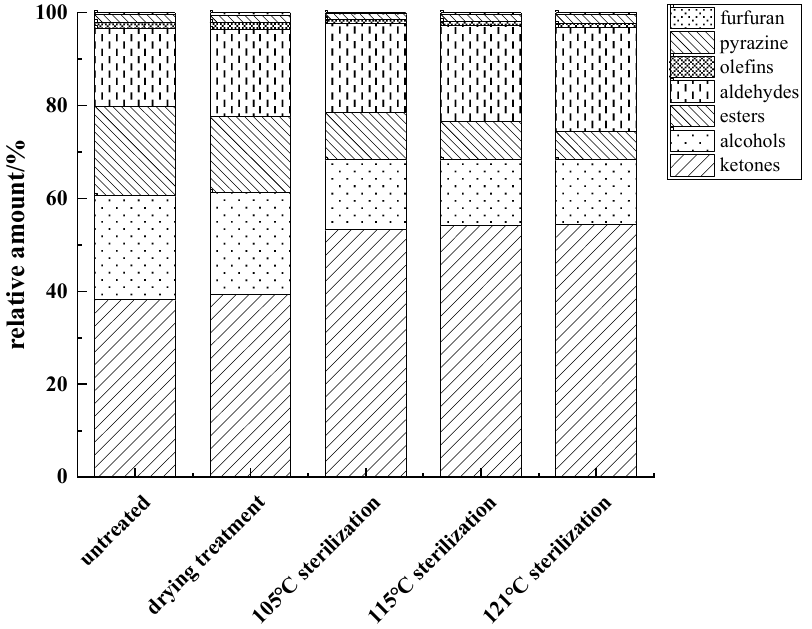
Figure 6. Relative content changes of volatile components in tilapia fish cakes with different processing methods.